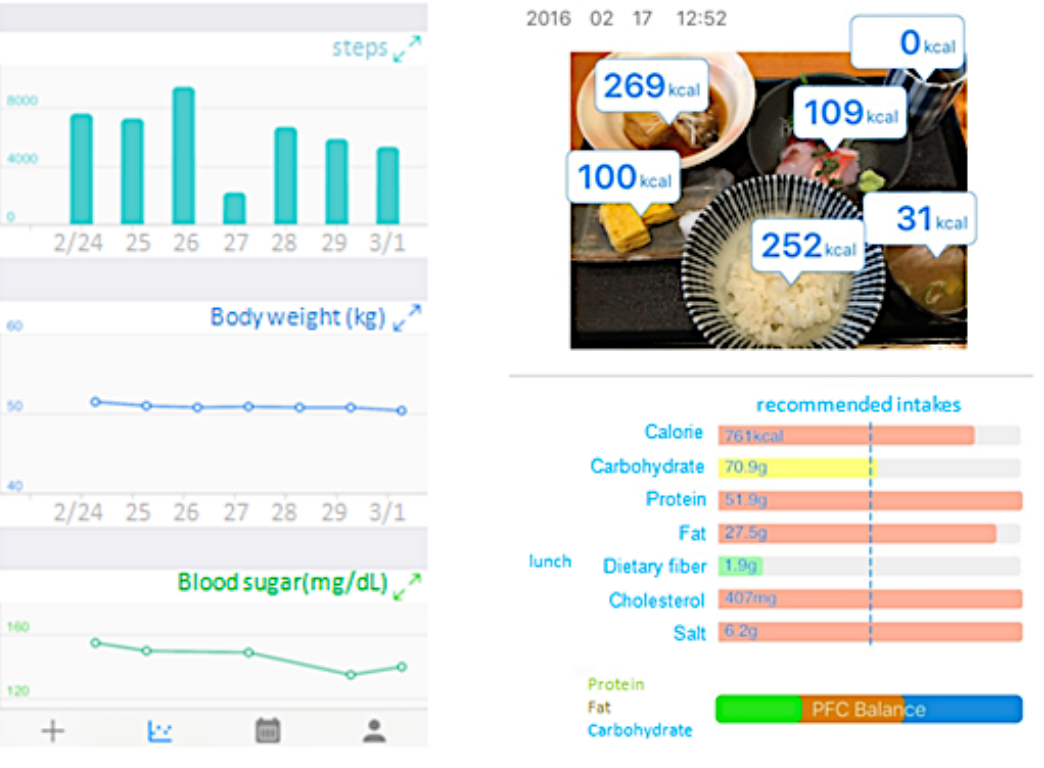
Figure 1. Sample view of GlucoNote